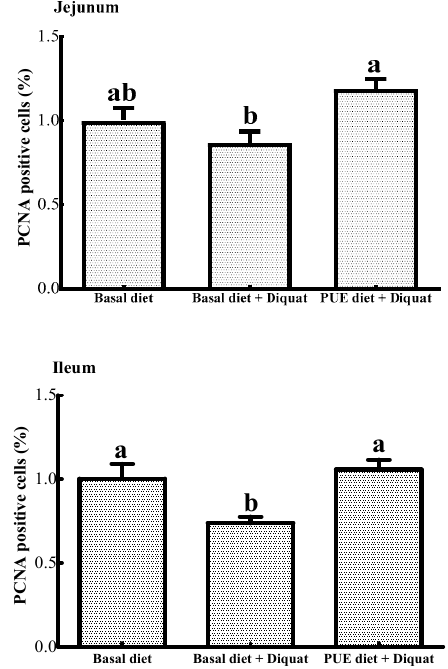
Figure 1. The percentage of proliferating cell nuclear antigen (PCNA) positive cells in the jejunum and ileum of the piglets. Data are expressed as means ± SEM, n =8. a,b Values with different lowercase letters are different ( p < 0.05).